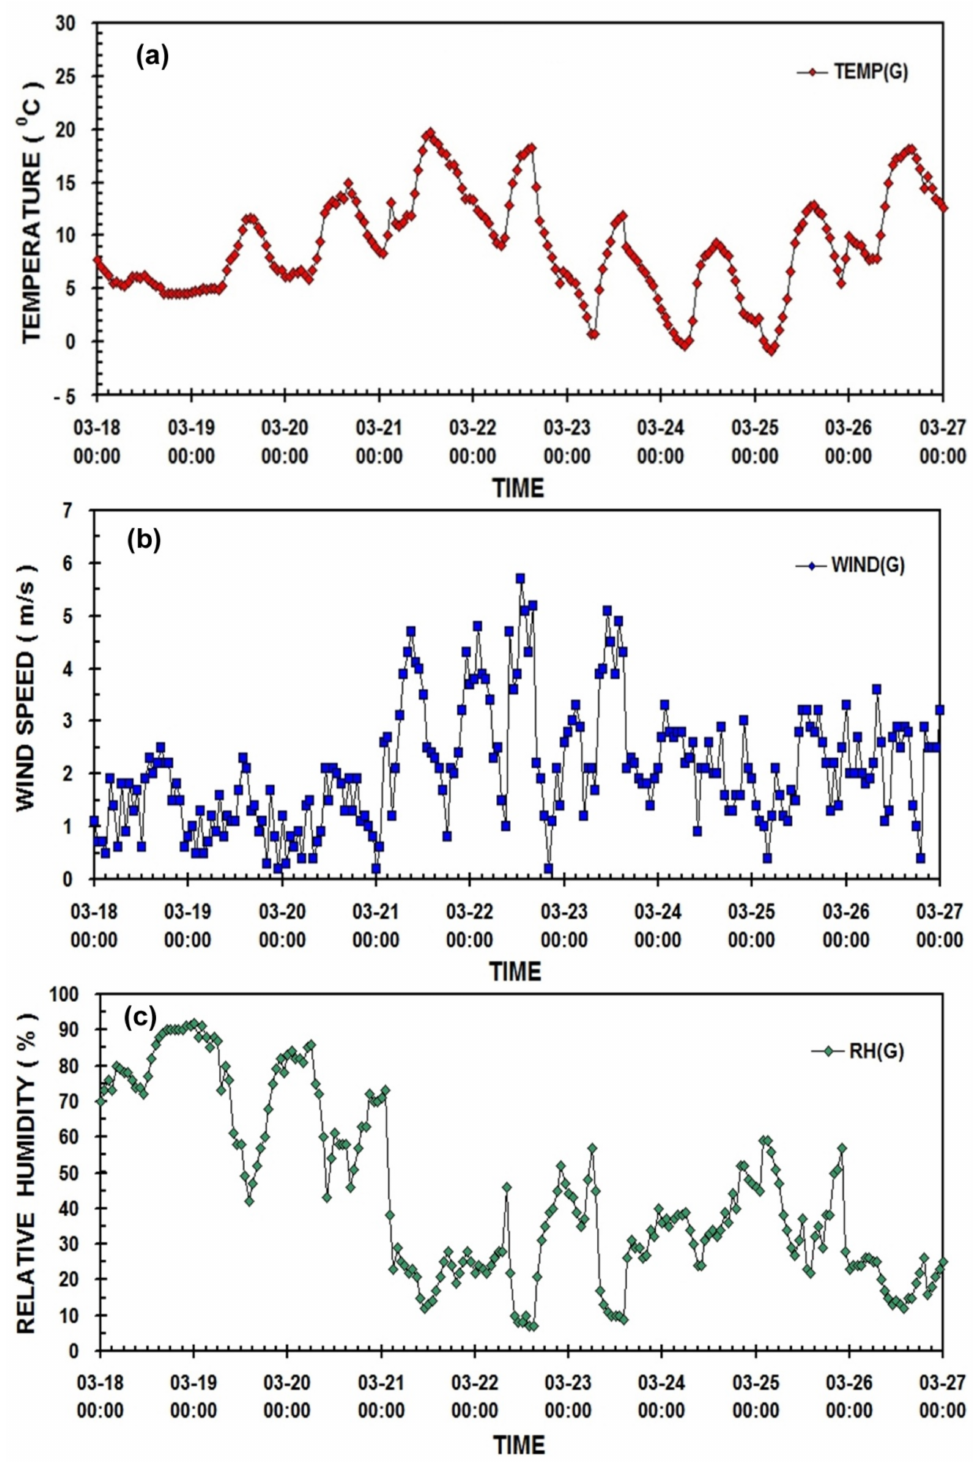
Figure 5. Hourly distributions of ( a ) air temperature ( ◦ C), ( b ) wind speed (m/s) and ( c ) rela- tive humidity (%) corresponding to PMs concentrations from 18 March to 27, 2015 in Gangneung city,